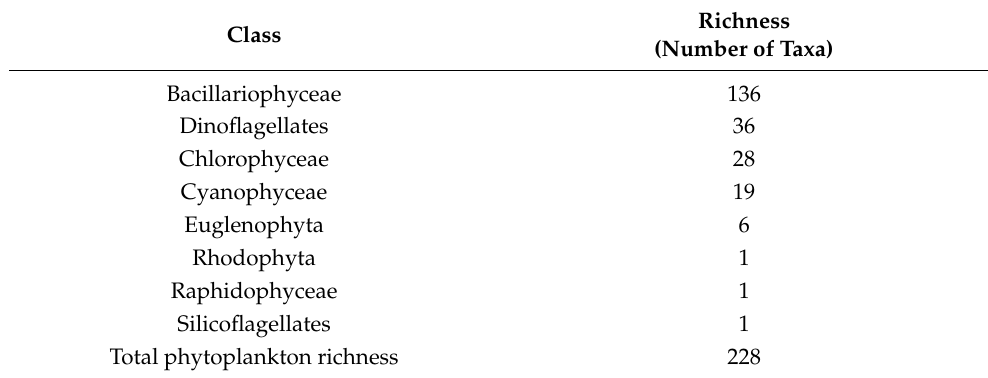
Table 3. Richness of the main phytoplankton groups recorded from Alexandria